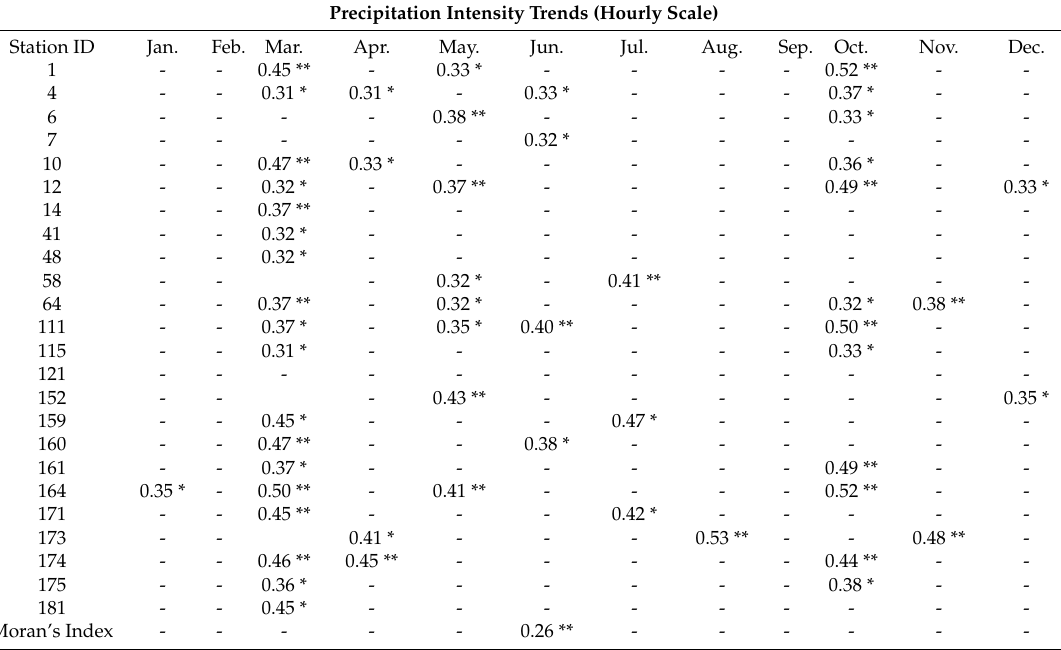
Table A1. Kendall’s Tau values for monthly precipitation intensity trends using hourly scale